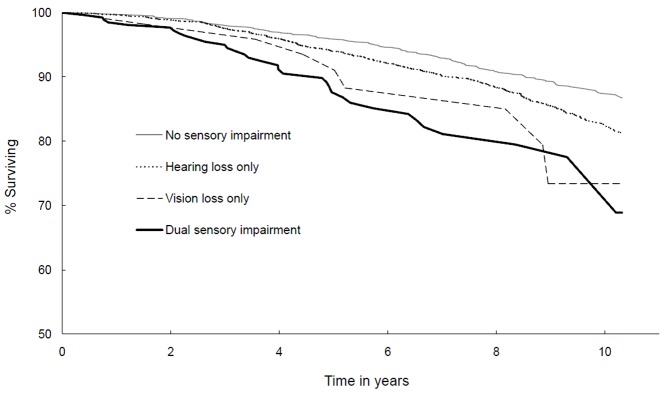
Age-sex adjusted Kaplan-Meier survival curves by presence of sensory impairment (presenting bilateral visual impairment and/or bilateral hearing impairment) among Blue Mountains Eye Study participants aged 55 years and older (n = 2806).